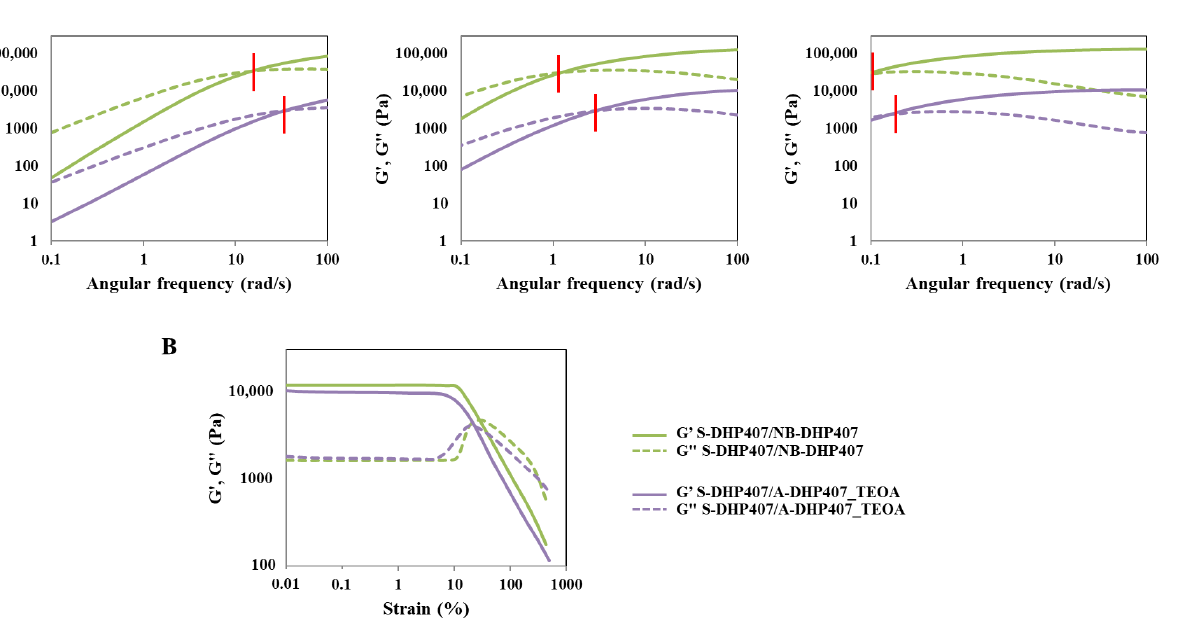
Figure 12. Frequency sweep tests at 25 °C, 30 °C and 37 °C (from left to right) ( A ), and strain sweep test at physiological temperature ( B ) performed on S-DHP407/NB-DHP407 (green) and S-DHP407/A-DHP407_TEOA (violet) formulations after exposure to visible light (525 nm, 80,000 Lux, 10 min). For higher clarity, G’ and G” values of S-DHP407/A-DHP407_TEOA formulations measured through frequency sweep test were divided by a factor of 10.